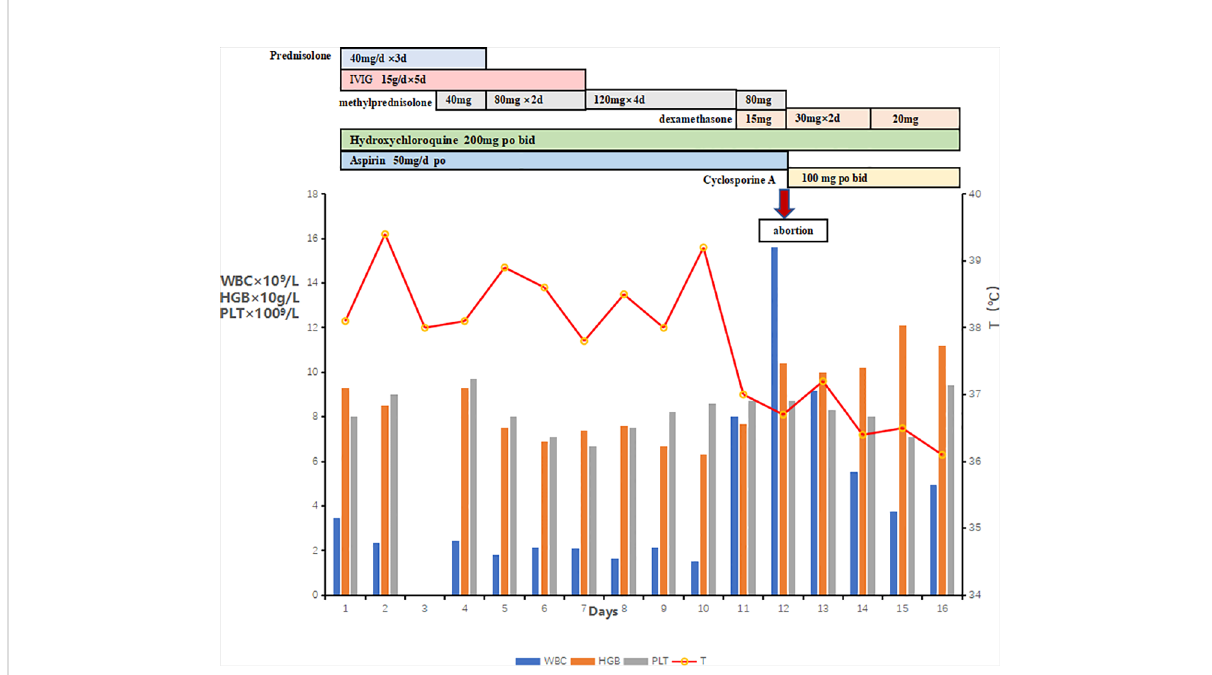
FIGURE 1 Medications administered, and changes in WBC, HGB, PLT, and body temperature are shown.